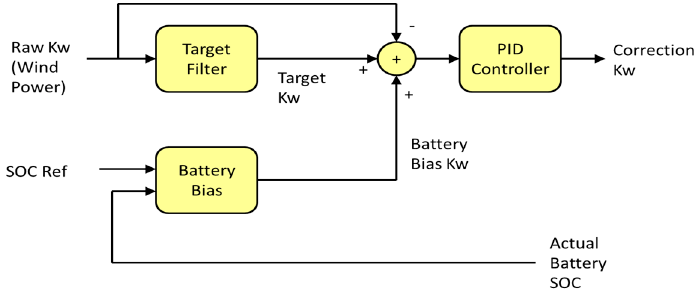
Figure 11. Schematic of the wind smoothing control algorithm.